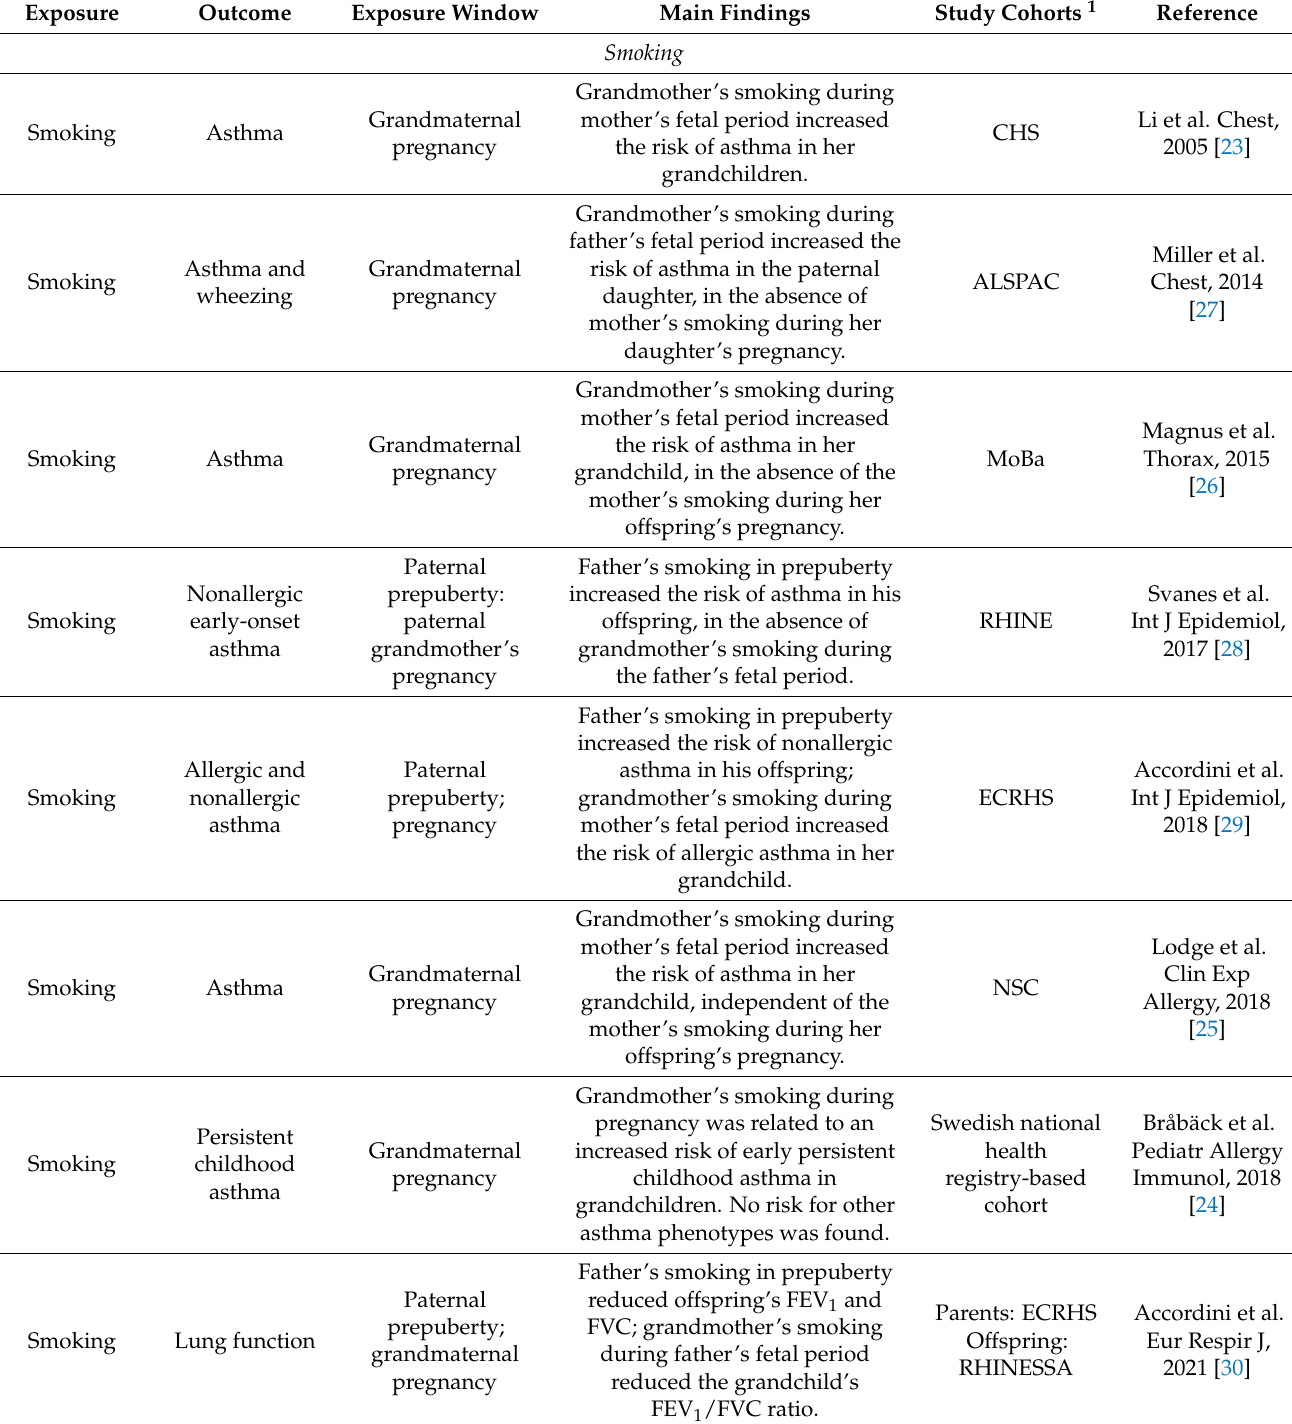
Table 1. Summary of multigeneration human studies associating preconception environmental exposures to asthma, allergies, and lung